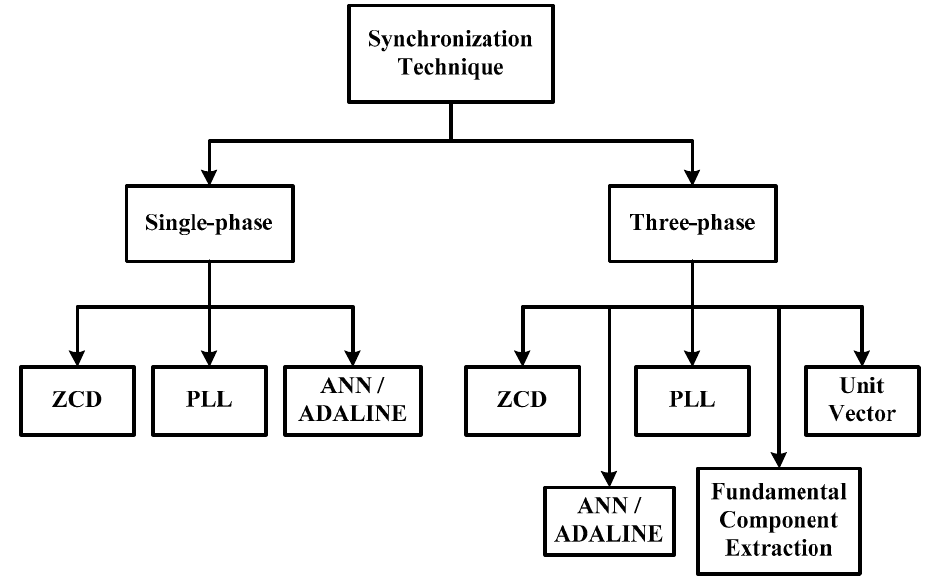
Figure 3. Overview of synchronization techniques applied to SAPF. ZCD: zero-crossing detection; PLL: phase-locked loop; ANN: artificial neural network; ADALINE: adaptive linear neuron.